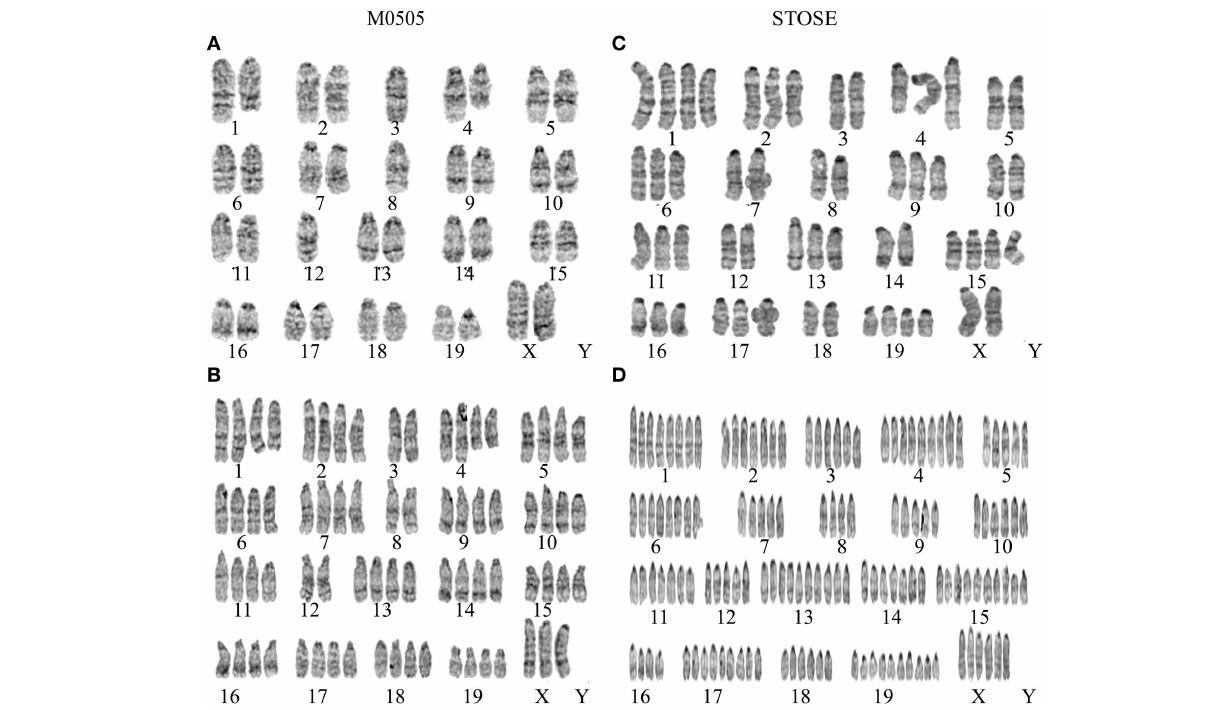
FIGURE 2 | Chromosomal analysis of M0505 and STOSE cell lines. G-band karyotyping of five metaphase spreads was performed for both M0505 and STOSE cell lines and representative karyotypes are presented. (A) Near- diploid M0505 cell with 37 chromosomes. (B) Near-tetraploid M0505 cell with 75 chromosomes. (A,B) Terminal deletion of chromosomes 1 and 4 as well as